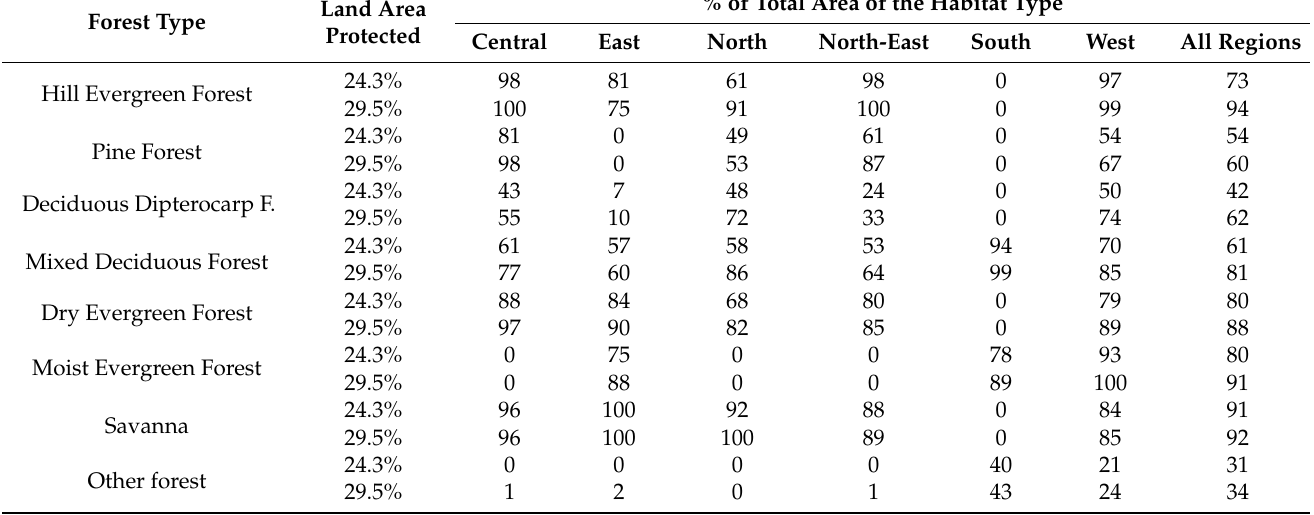
Table 2. Representation of forest types in protected areas in Thailand by region, currently (with 24.3% of the land area protected) and with expansion (29.5% protected). Vegetation from the Royal Forest Department [12].